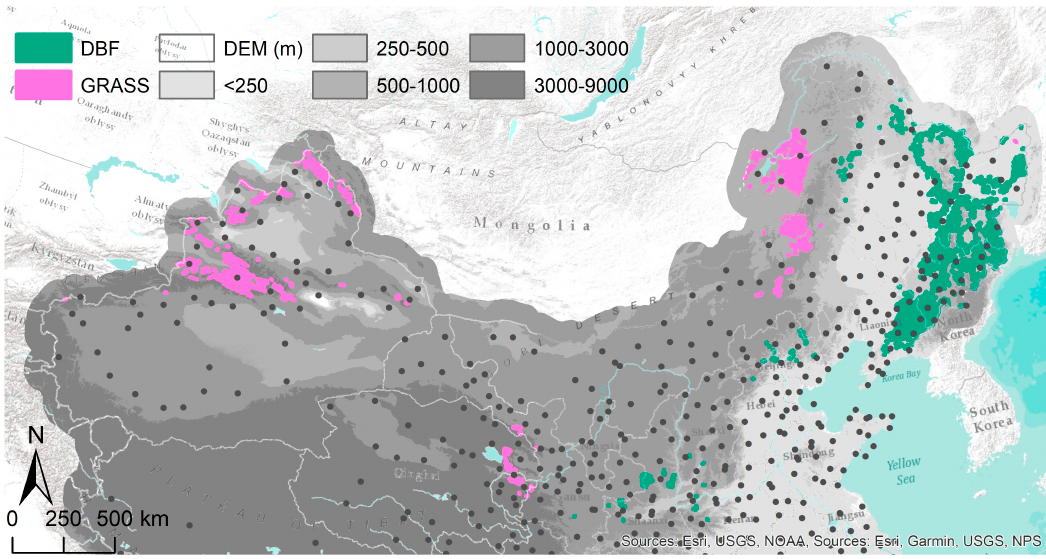
Figure 1. Locations of temperate deciduous-broadleaved forest (DBF) and grassland (GRASS) patches selected in Northern China. Dots indicate weather stations.